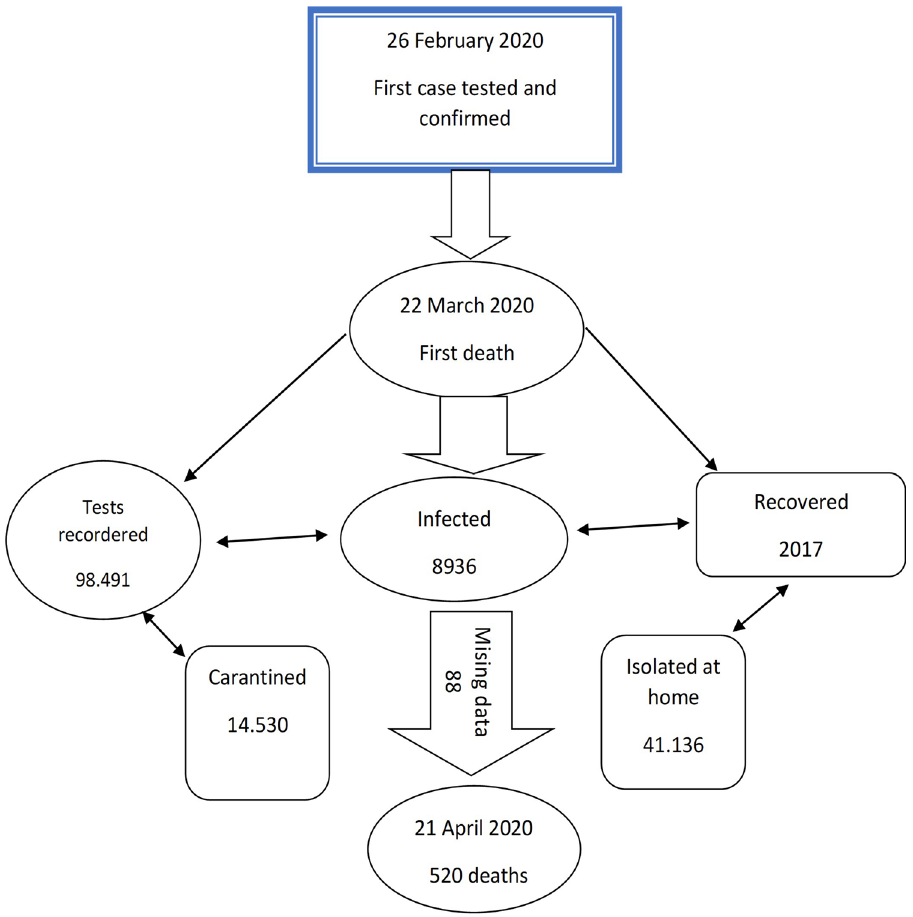
Figure 1. History of SARS-COV-2 pandemic in Romania up to April